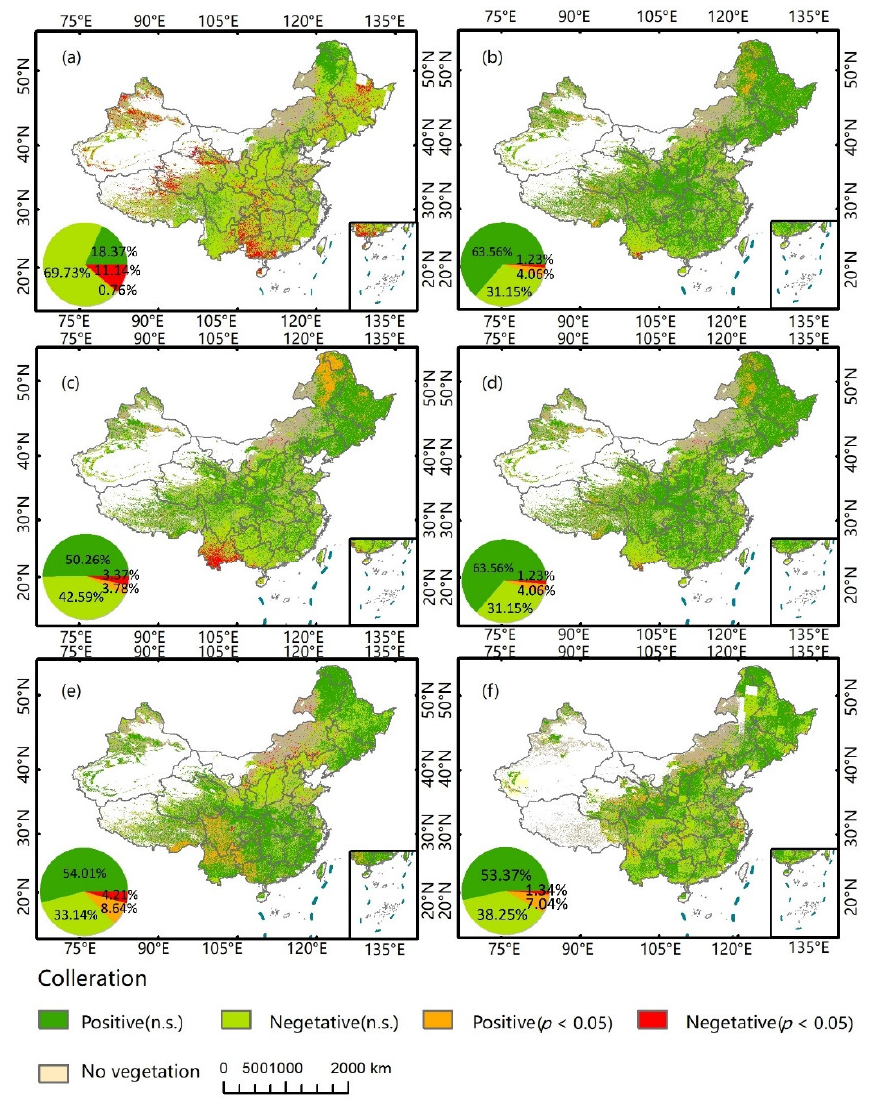
Figure 9. Spatial correlation between the NDVI and climate extremes indices in China over the 1998–2018 period. Positive/Negative (n.s.) represents positive/negative correlation that did not pass the significance test. Positive/Negative ( p < 0.05) indicates positive/negative correlation at 95% significance level: ( a ) DTR ( ◦ C); ( b ) TNn ( ◦ C); ( c ) TXn ( ◦ C); ( d ) Rx5day (mm); ( e ) TXx ( ◦ C); ( f ) Rx1day (mm). A bar chart showing the statistics is placed inside each map.